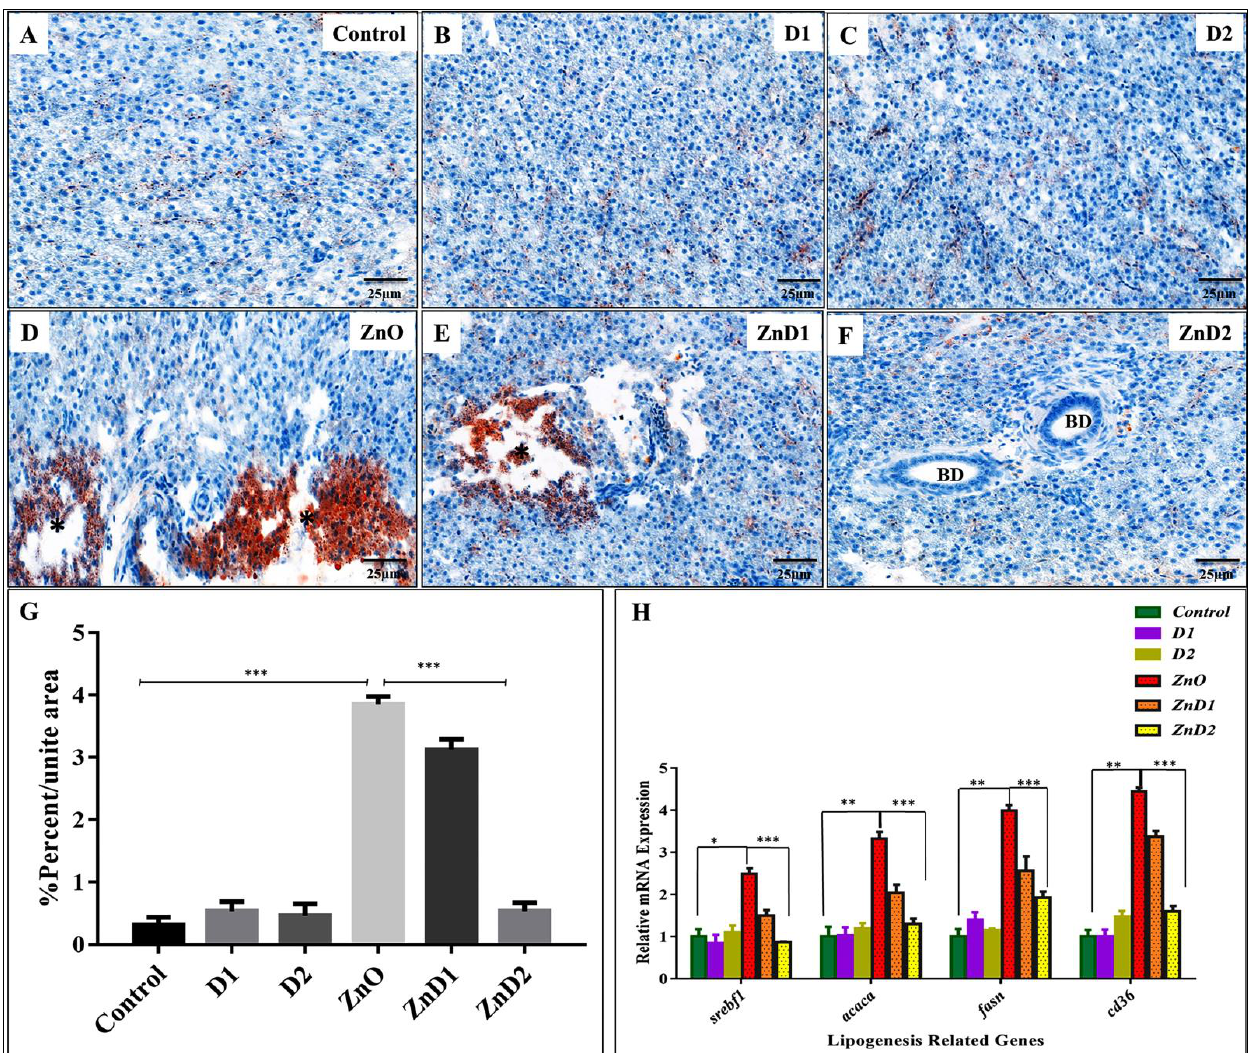
Figure 6. D. salina reduced hepatic steatosis induced by ZnO-NPs: ( A ) – ( C ) ORO staining of the liver in Control, D1, and D2 groups showing normal hepatocytes and a significant lipid reduction; ( D ) ORO staining of ZnO-NPs exposed group liver showing tissue degeneration (Black strikes) with lipid accumulation (Red staining); ( E ) ORO staining of ZnD1 liver showing a transition state of lipid reduction; ( F ) ORO staining of ZnD2 liver exhibiting complete recovery with significant dilation of bile ducts; ( G ) statistical analysis of ORO photomicrographs presenting the induced action of ZnO-NPs in lipid elevation and the therapeutic effect of D. salina ; ( H ) expressions of mRNA were evaluated by qRT-PCR for lipogenesis-related genes revealing overexpression in the ZnO-NPs group compared with their siblings from the control, D1, and D2 males. In the ZnD2 group, the expression of genes was downregulated. Scale magnifications are shown in pictures and data expressed as mean ± SD. * p < 0.05 (significant), ** p < 0.01 (highly significant), *** p < 0.001 (very high